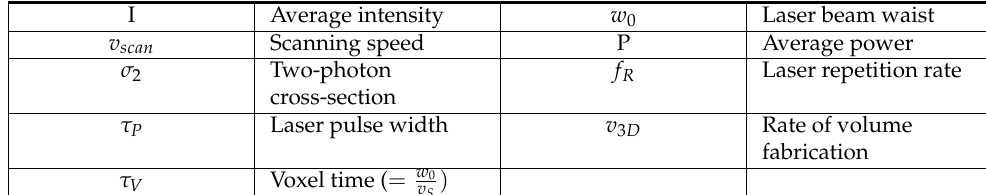
Table 2. Physical symbols describing the main features of pulsed lasers used for MPL fabrication. I Average intensity w 0 Laser beam waist v scan Scanning speed P Average power σ 2 Two-photon